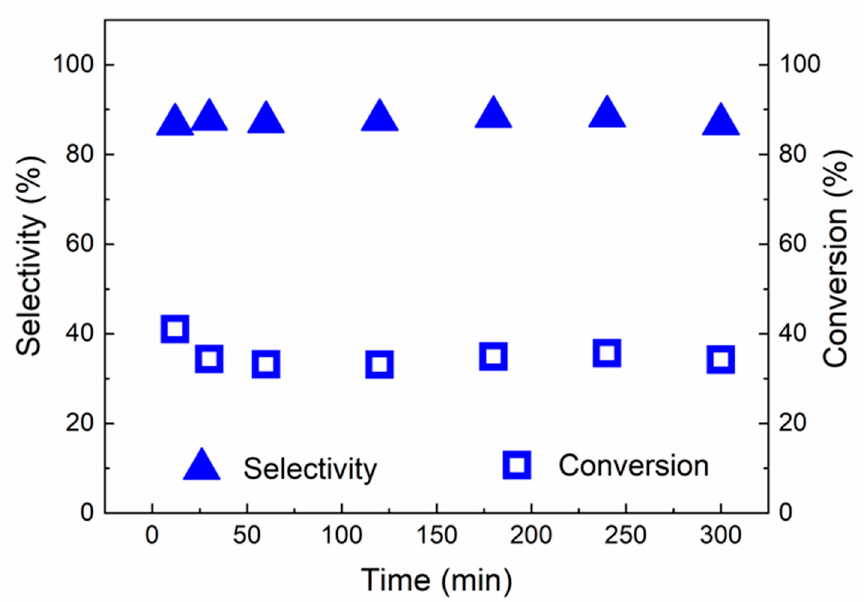
Figure 12. Catalytic behaviour of red(600 ◦ C)-Pd/ γ -Al 2 O 3 in hydrogenation of 2-methy-3-butyn-2-ol as a function of time on stream at 25 ◦ C and 5 bar.